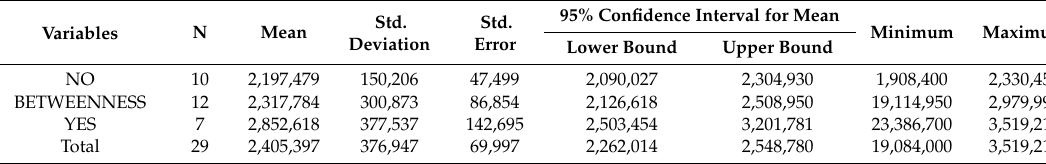
Table 4. One-way descriptive statistics (Y11).